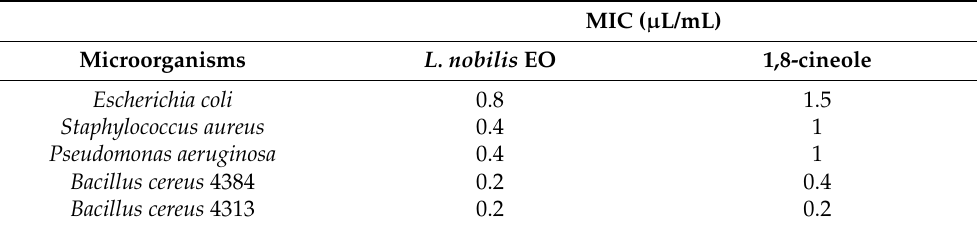
Table 3. Minimal inhibitory concentration of L. nobilis EO and 1,8-cineole, reproduced from [11]. MIC ( µ L/mL) Microorganisms L. nobilis EO 1,8-cineole Escherichia coli 0.8 1.5 Staphylococcus aureus 0.4 1 Pseudomonas aeruginosa 0.4 1 Bacillus cereus